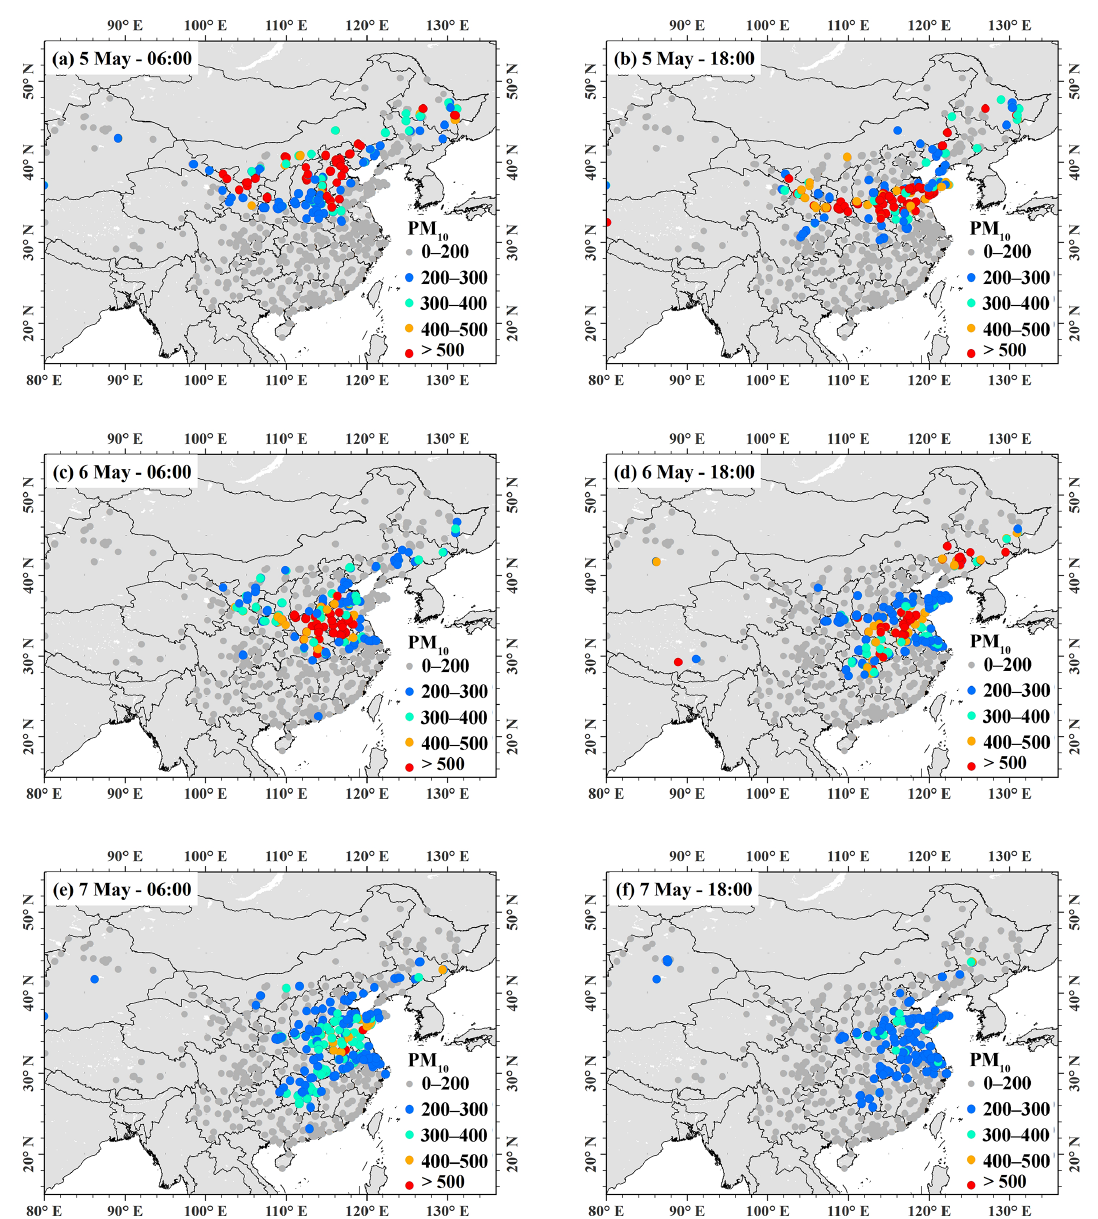
Figure 8. PM 10 mass concentrations measured by ground-based air quality stations in mainland China over a 12h interval from 06:00 to 18:00 during 5–7